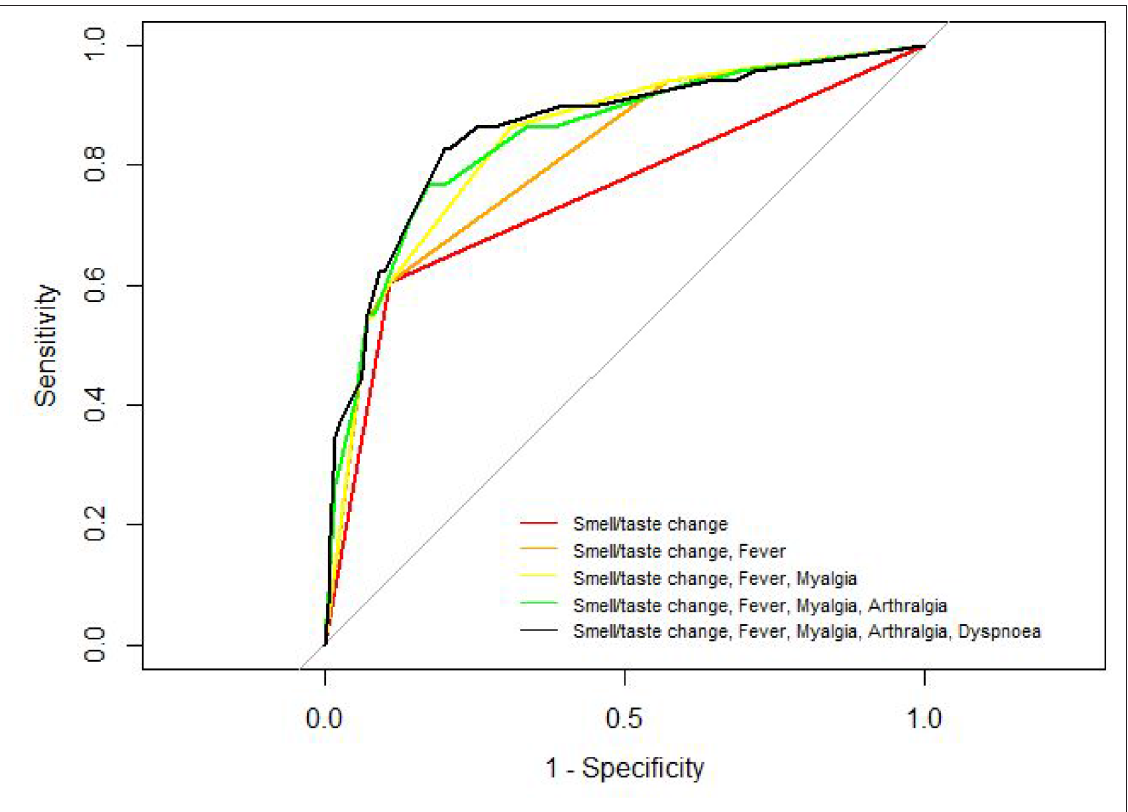
Figure 3 Receiver operating characteristic (ROC) plots for symptom classifier models. The dashed diagonal line shows a non- diagnostic result. Area under the curve (AUC) for each symptom classifier group is displayed in Table 2. (A non- colour dependent version of this figure is available in the supplementary